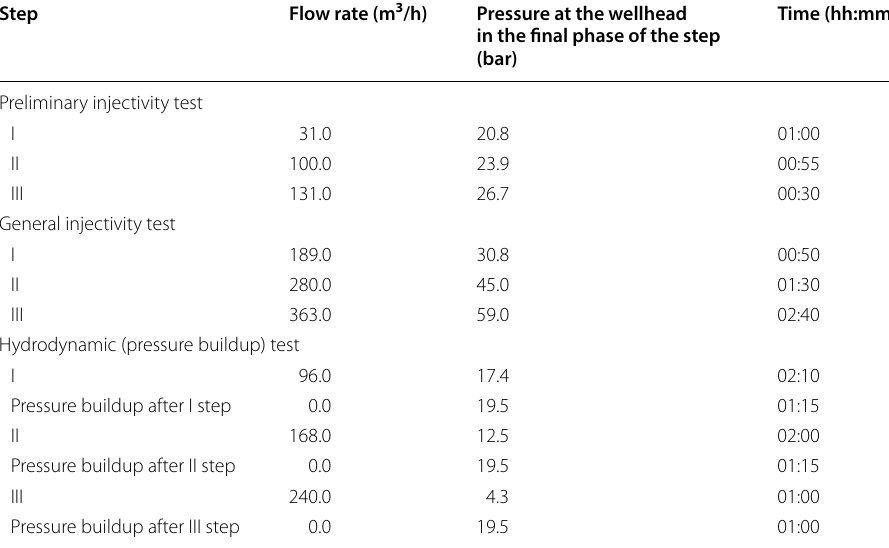
Table 2 Summary of the results of hydrogeological tests conducted in the Biały Dunajec PAN-1 well after its reconstruction in 2015 (Bujakowski et al. 2015) Step Flow rate (m 3 /h) Pressure at the wellhead in the final phase of the